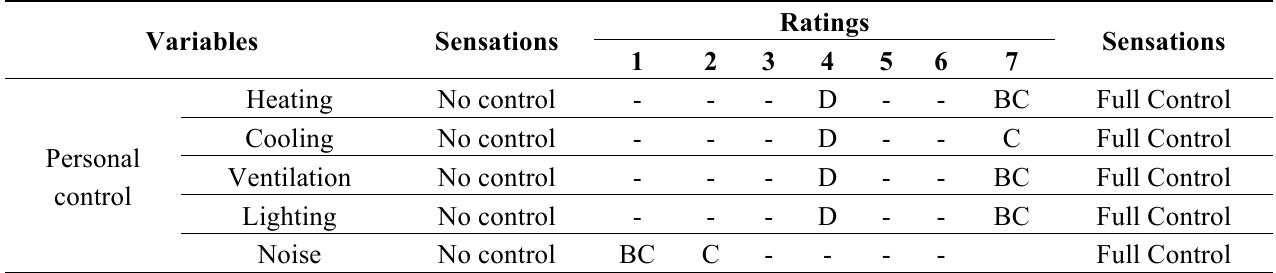
Table 4. Building Use Studies (BUS) surveys: Building user control on environmental